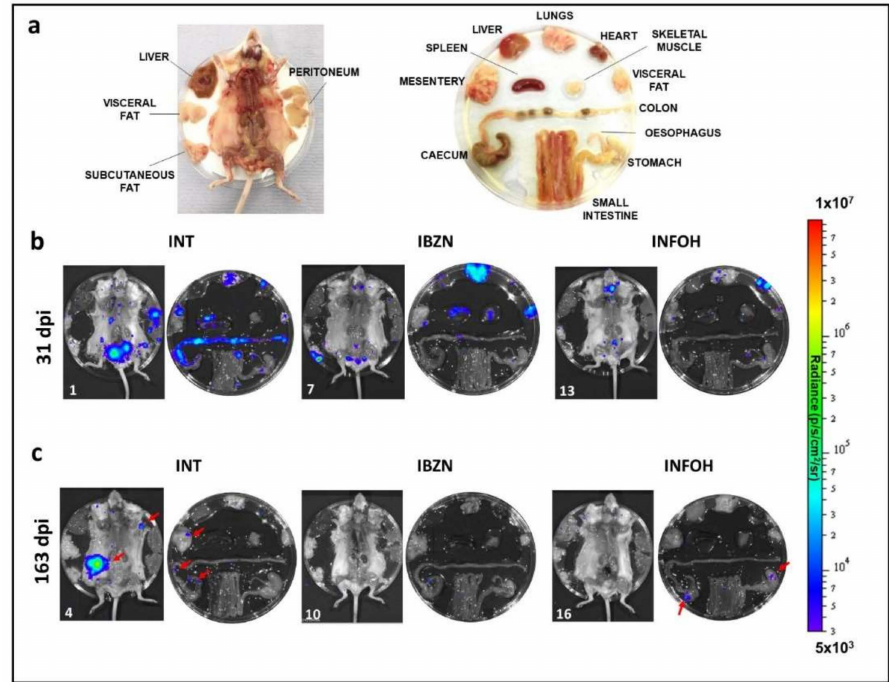
Figure 4. Ex vivo assessment of NFOH against acute and chronic stage T. cruzi infections. ( a ) Schematic display of carcass, organs and tissues. ( b ) Organs from representative mice treated